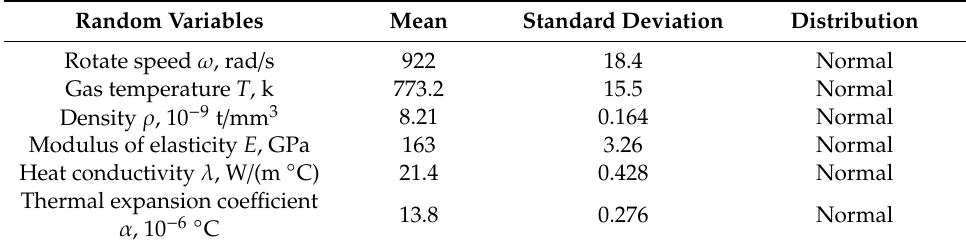
Table 1. Distribution characteristics of physical